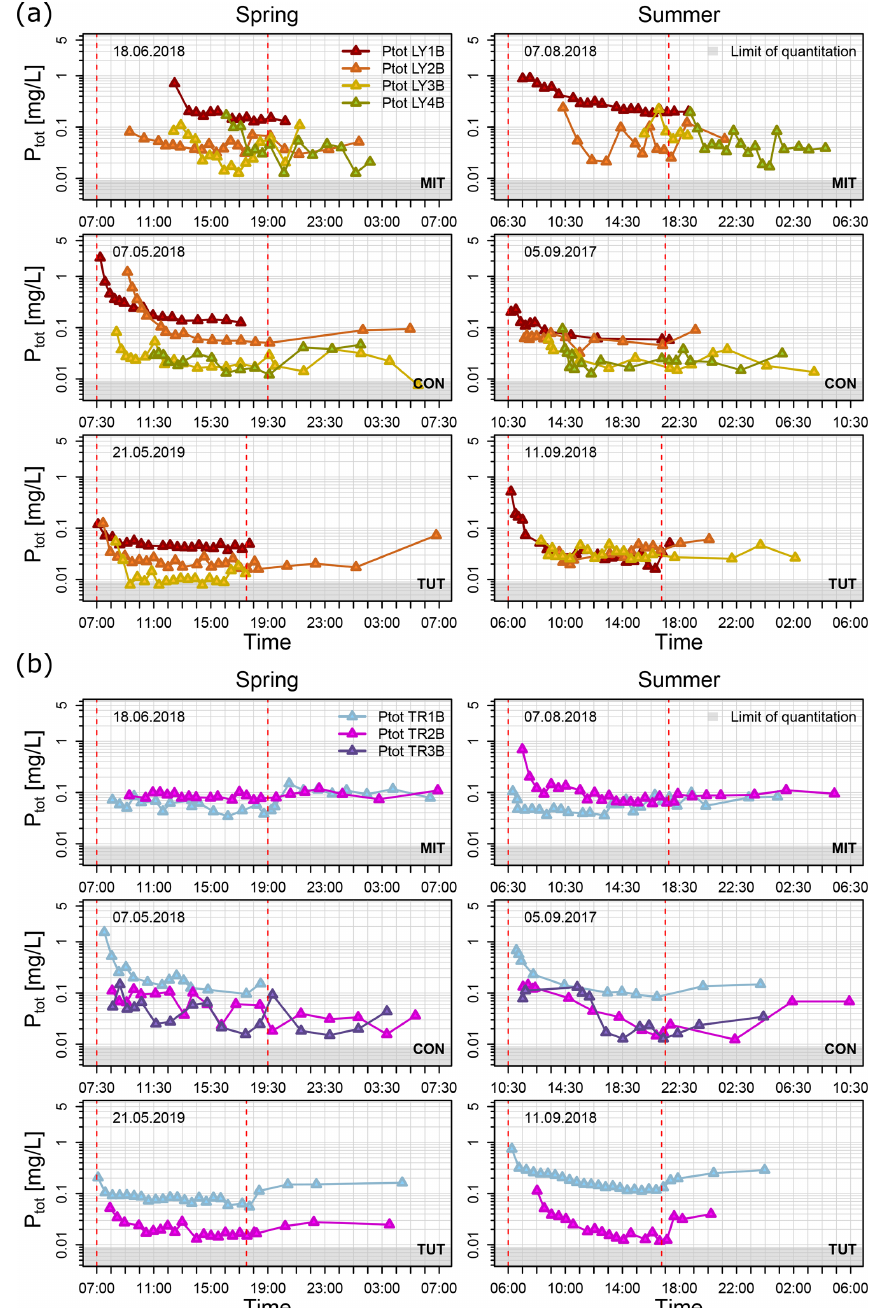
Figure 4. P tot concentrations of (a) vertical subsurface flow and (b) lateral subsurface flow for the sprinkling experiments in Mitterfels (MIT), Conventwald (CON) and Tuttlingen (TUT) sorted in rows for spring (left column) and summer (right column). Dashed red lines indicate the start and end of the sprinkling experiment, and light gray areas indicate the range of P tot below the limit of quantitation.